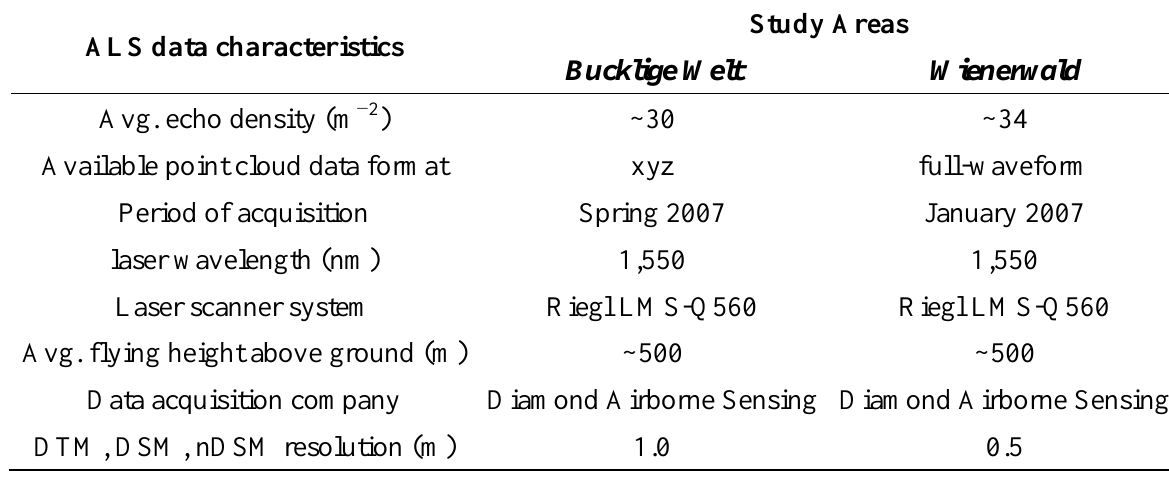
Table 2. Characteristics of the used FWF-ALS